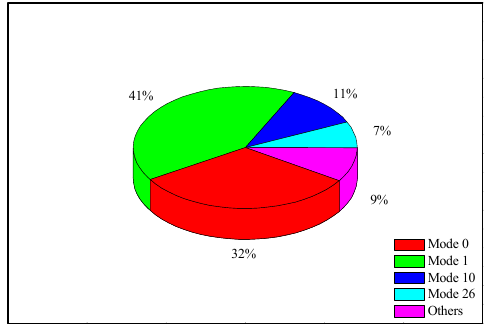
Figure 4. The rate of optimal mode selections in cases of large coding unit (CU) size ( CU size = 64 × 64 and 32 × 32).